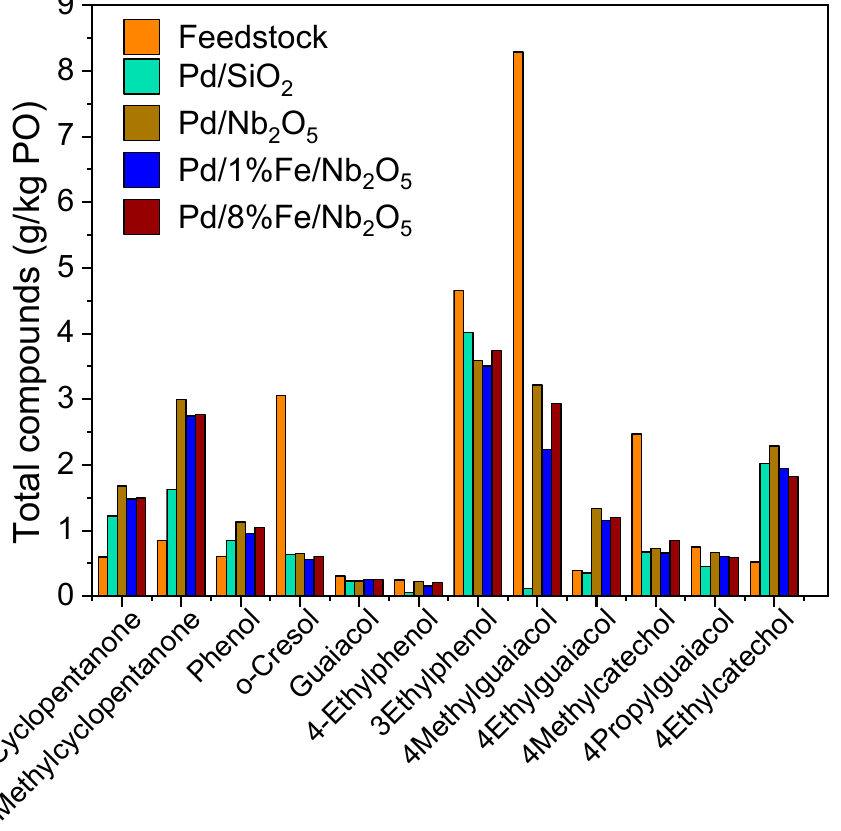
Figure 9. Total amount of representative oxygenated compounds after the upgrading, considering the sum of aqueous phase and upgraded oil, as well as the amount present on feedstock (Pyrolysis oil light phase).